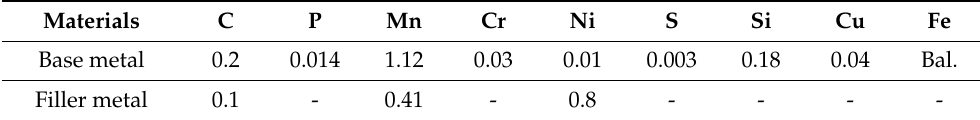
Figure 1. Microstructure of the Q345 base metal. Table 1. Chemical composition of the base material and filler metal (wt.%).